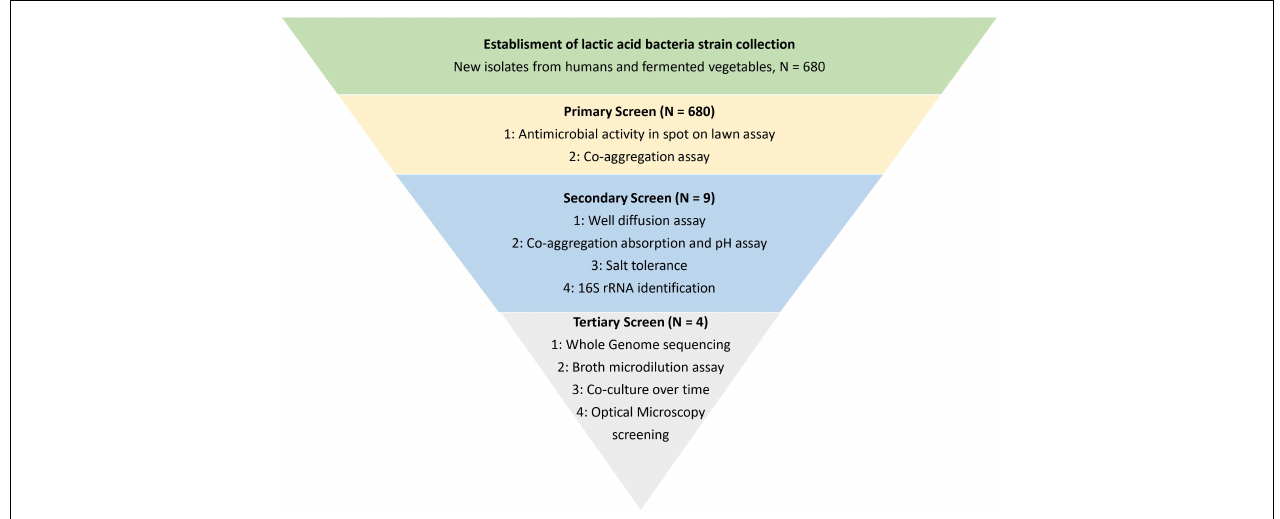
FIGURE 1 | Schematic overview of the study. The study was divided into three screening parts for identification and characterization of lactic acid bacteria with antimicrobial activity toward Staphylococcus aureus CC-type 1. The screening was performed to narrow down the library of 680 lactic acid bacteria strains to four strains with the highest observed antibacterial